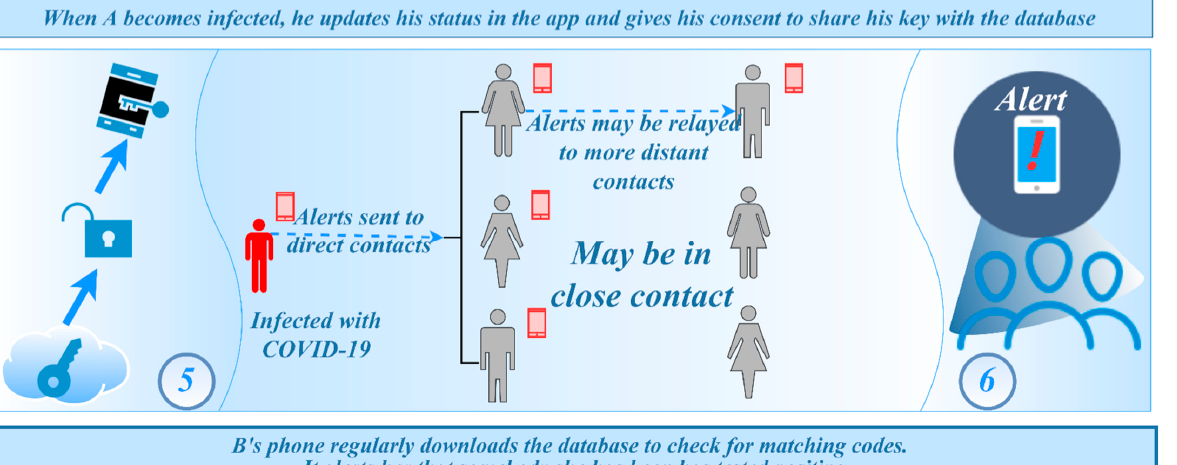
Figure 7. Sketch-map of Bluetooth wireless technology virus-tracking mechanism. (Note: Step 1: effective contact distance for collecting close contacts’ information; Step 2: When close contact conditions are reached, the mobile device starts recording information; Step 3: Someone get a positive PCR test result for COVID-19 (coronavirus) and confirmed cases were screened; Step 4: Through the cloud data, the records of the confirmer's equipment are retrieved to obtain the people who have had close contact behaviors; Step 5: The background system will automatically pair through the key of the confirmed patient, and obtain the bluetooth signal key of all the user's mobile phones that they have been in close contact with within a period of time; Step 6: Once a confirmed case appears, the mobile phone that has been in close contact with the patient's mobile phone will also automatically warn its owner, reminding its owner that the person you have been in contact with has been diagnosed and needs self-quarantine and seek medical treatment as soon as